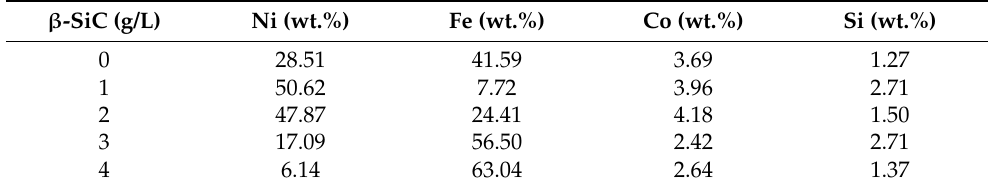
Table 5. Mass fraction of the elements in the coating with different nanoparticle concentrations after wear. β -SiC